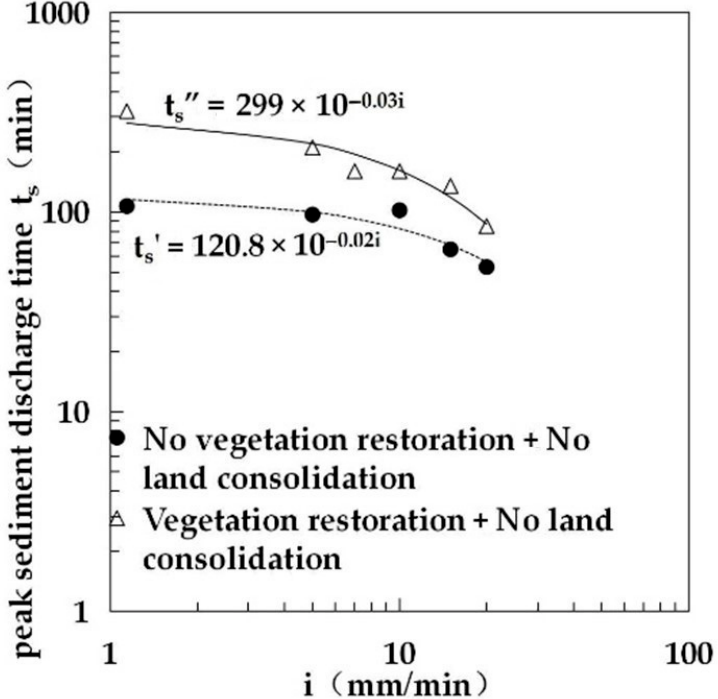
Figure 16. Changes in peak sediment discharge time with rain intensity before and after control.